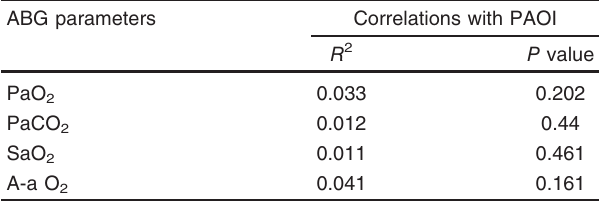
Table 2 Correlations between pulmonary artery obstructive index and arterial-blood gas parameters ABG parameters Correlations with